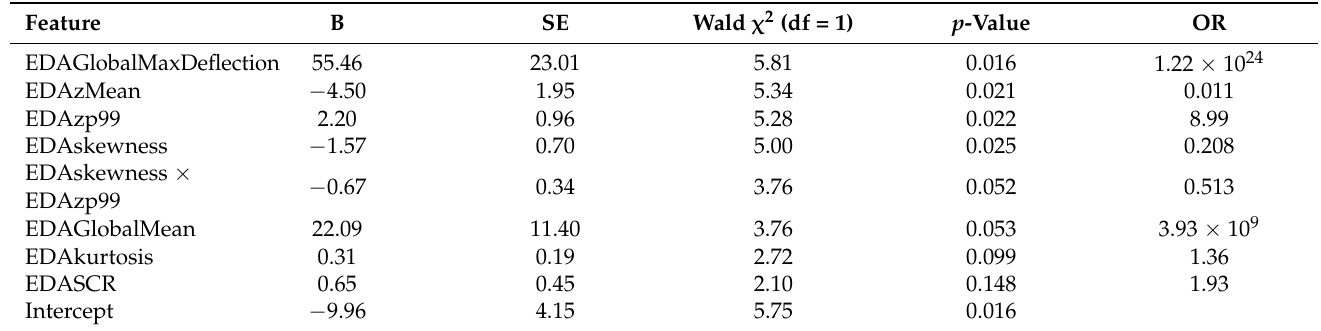
Table 2. Parameter estimates, odds ratios (OR) and corresponding hypothesis tests in order of variable importance. p -values are calculated with respect to H 0 : B = 0, OR =